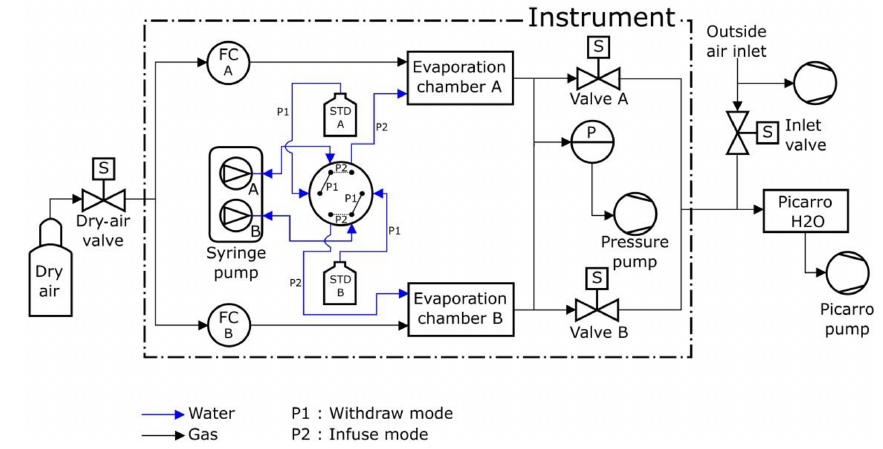
Figure 2. Humidity generator schematic diagram (see Table S1 in the Supplement for details on the different elements).